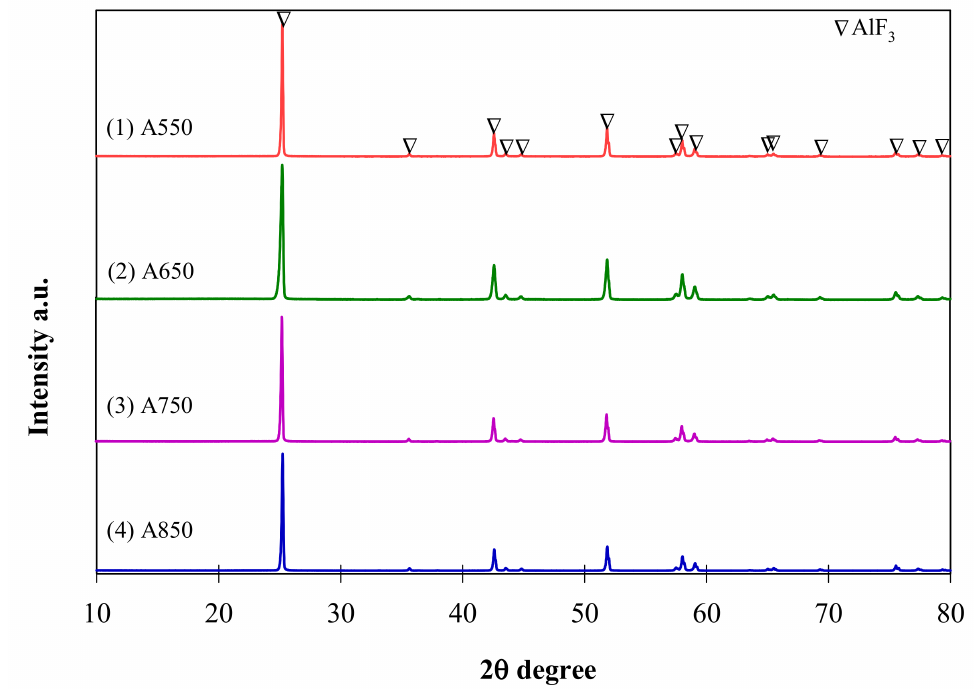
Figure 4. XRD patterns of spent γ -Al 2 O calcined at different